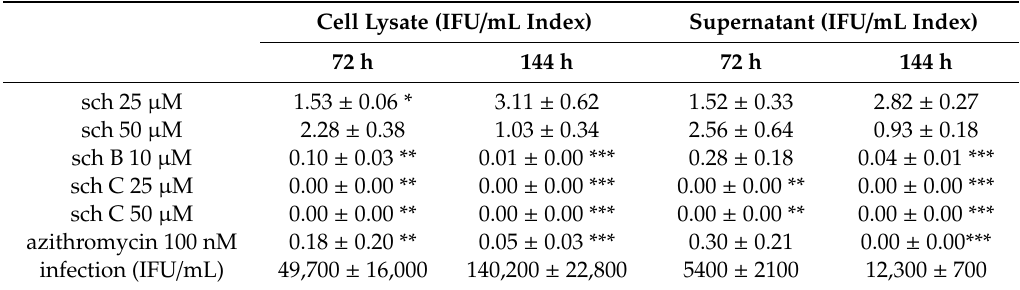
Table 2. The Impact of dibenzocyclooctadiene lignans on C. pneumoniae infectious progeny production. Cell Lysate (IFU / mL Index)